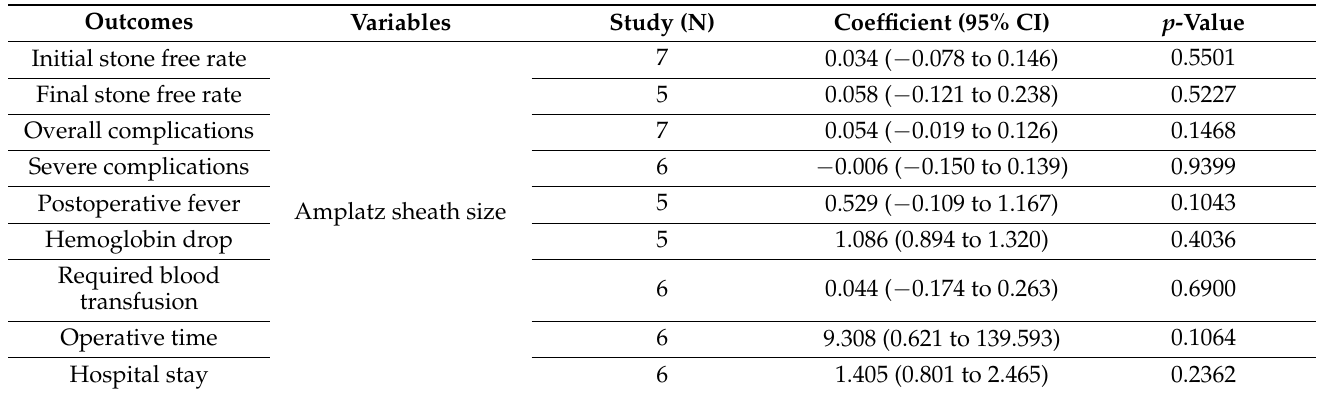
Table A9. Summary of the Result of Meta-Regression Analysis Regarding Outcome Measurements and Amplatz Sheath